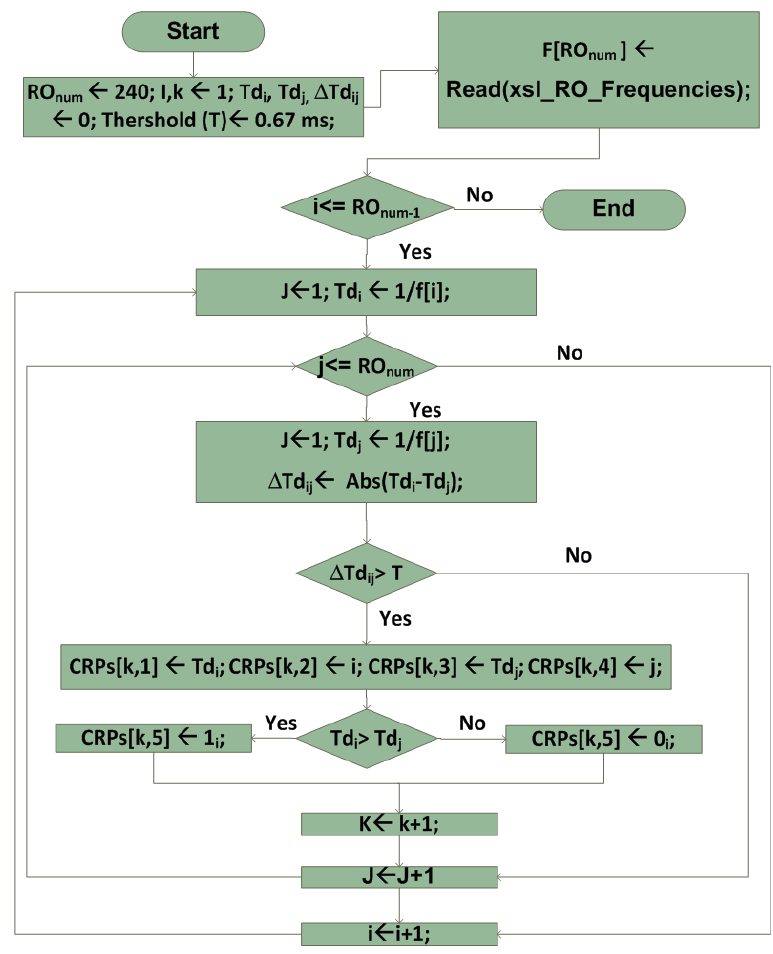
Figure 11. OTD algorithm step1: Reliable CRPs generation